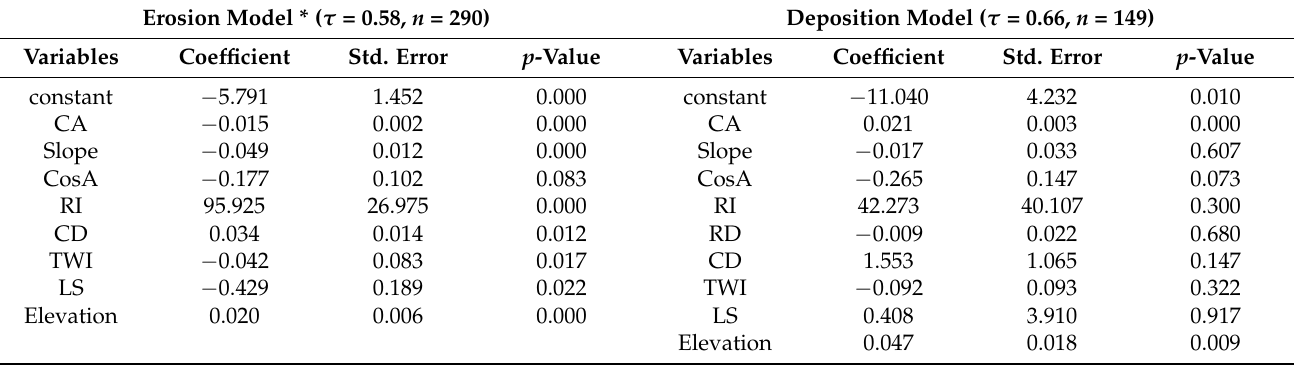
Table 8. Coefficients of the QR models for erosion and deposition (September–December